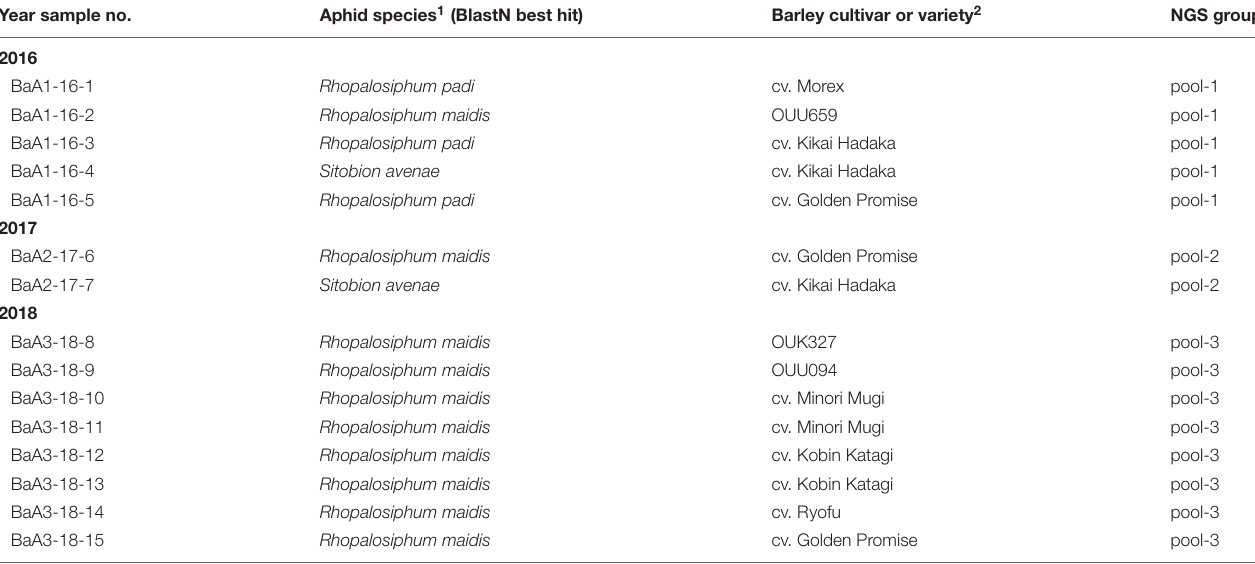
TABLE 1 | List of the aphid samples collected from the barley field. Year sample